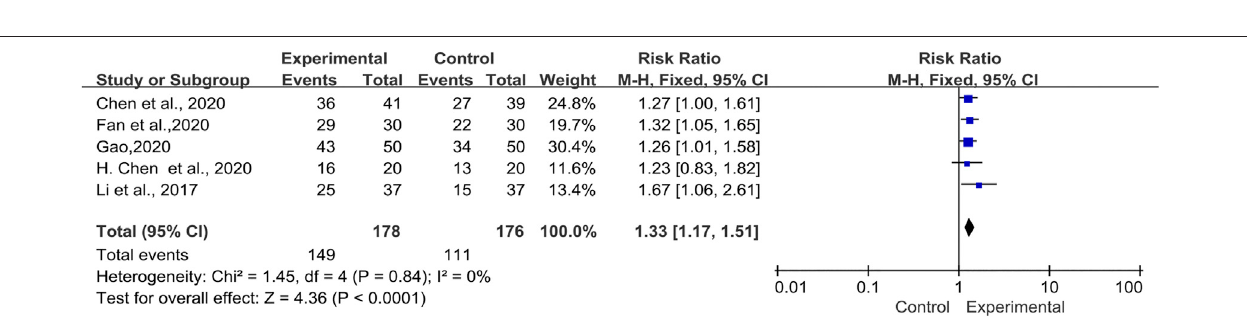
FIGURE 5 | Forest plot of clinical ef fi cacy with TwHF combined with conventional treatment versus pure conventional treatment.